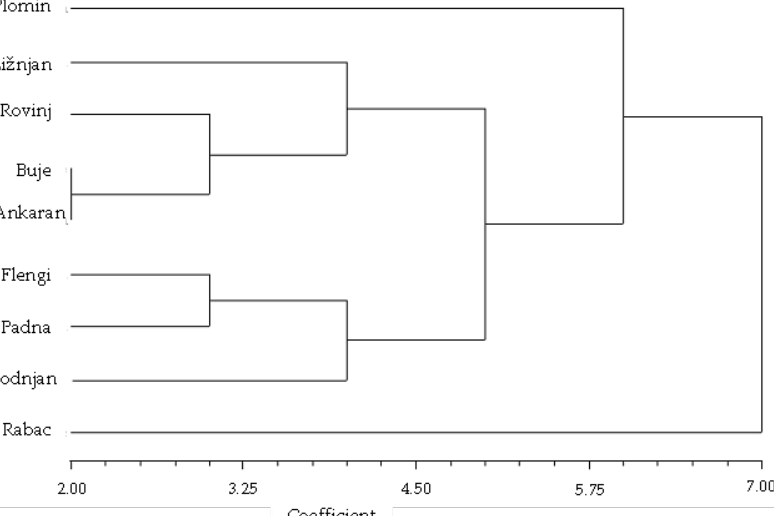
Figure 3. Phenogram of fennel populations reconstructed by Cavalli–Sforza and Edward’s chord distances [43] and neighbor-joining [45] using combined chemical and genetic data.